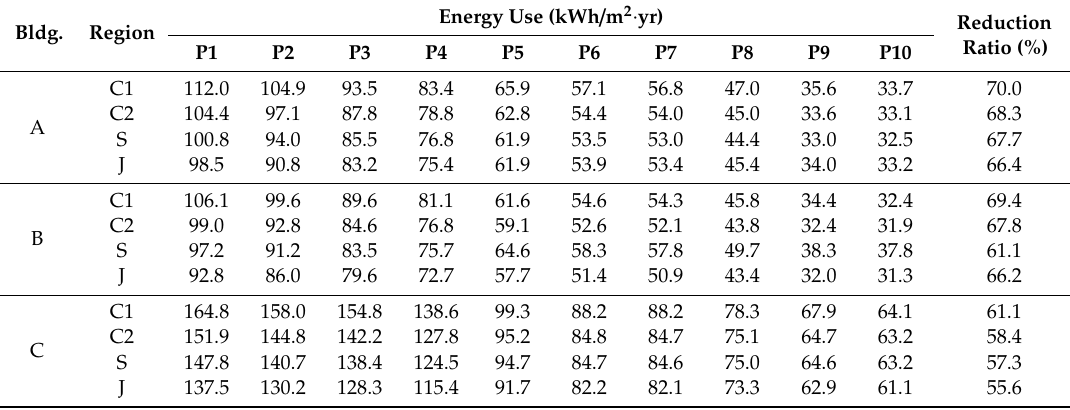
Table 11. The energy use of the reference buildings according to the reinforcement of the BECC.